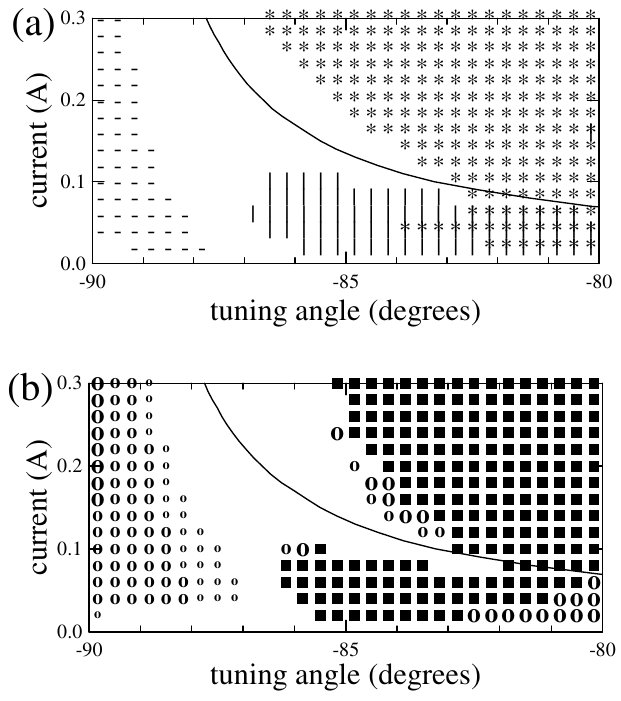
FIG. 3. Modeling for the Aladdin base lattice with worst-case parasitic coupled-bunch instability. A curve shows the parame- ters for optimal bunch lengthening. (a) Analytic predictions. –: parasitic coupled-bunch instability; |: coupled-dipole Robinson instability; *: coupled-quadrupole Robinson instability. (b) Results of 500 000-turn simulations of 60 000 macroparticles. o: mild instability, where the energy spread exceeds its natural value by (10–30)%; o : moderate instability, where the energy spread has increased by (30–100)%; O : strong instability, where the energy spread has increased more than 100%; (cid:1) : lost macro-